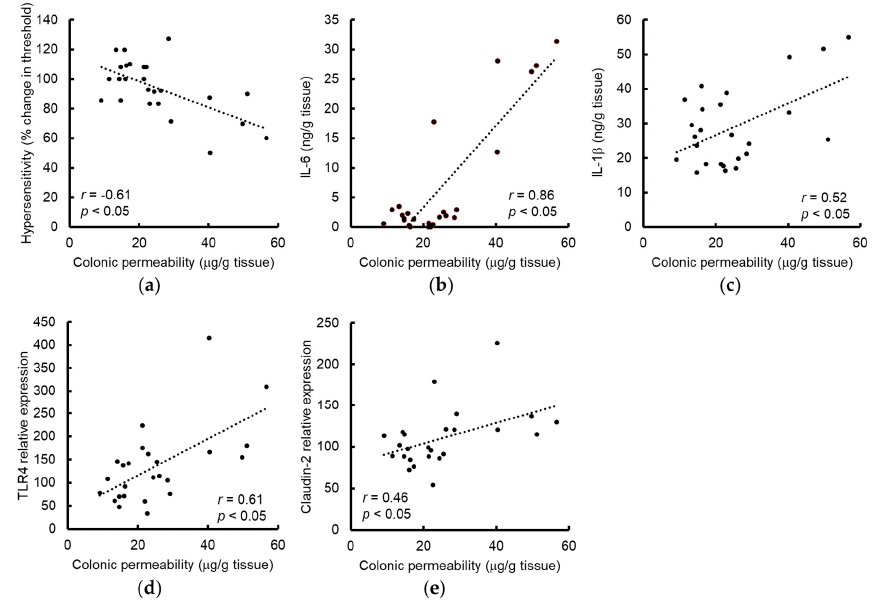
Figure 5. Correlations between colonic permeability and the parameters evaluated in rats from all treatment groups administered vehicle or GSE with or without WAS. The threshold of VMR showed a negative correlation with intestinal permeability ( a ). The level of IL-6 ( b ), IL-1 β ( c ), TLR4 ( d ) or claudin-2 ( e ) were positively correlated to intestinal permeability. Inset indicates Pearson’s r correlation and corresponding p -value. GSE, grape seed extract, IL, interleukin, TLR4, toll-like receptor 4, VMR, visceromotor response, WAS, water avoidance stress.